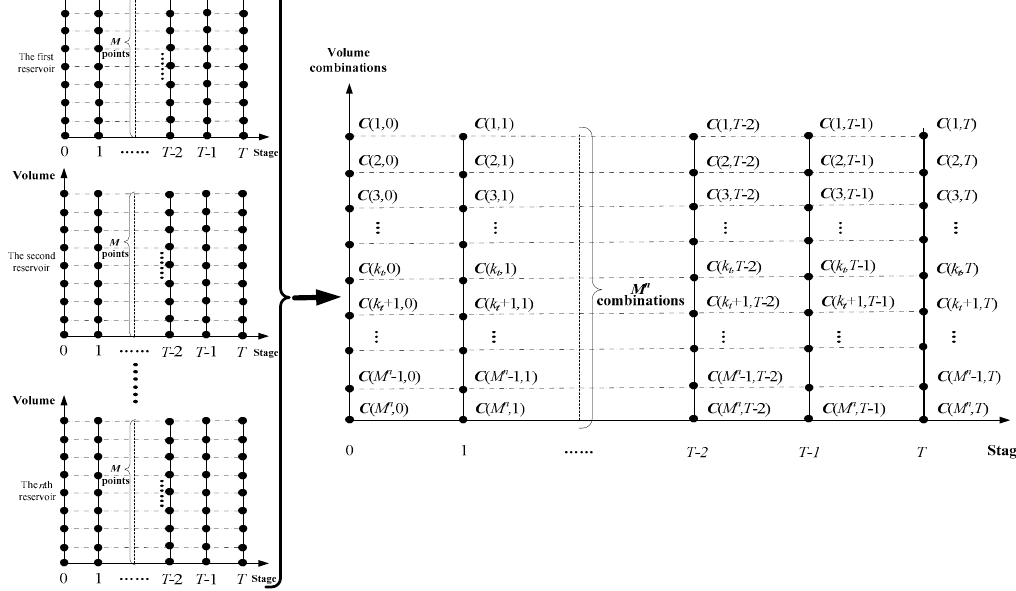
Figure 1. The discretization procedure of cascade reservoirs’ storage volume and their combination rule in Multi-dimensional Dynamic Programming (MDP).